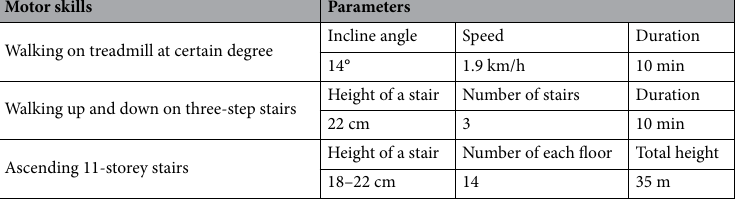
Table 1. Parameters of trial task